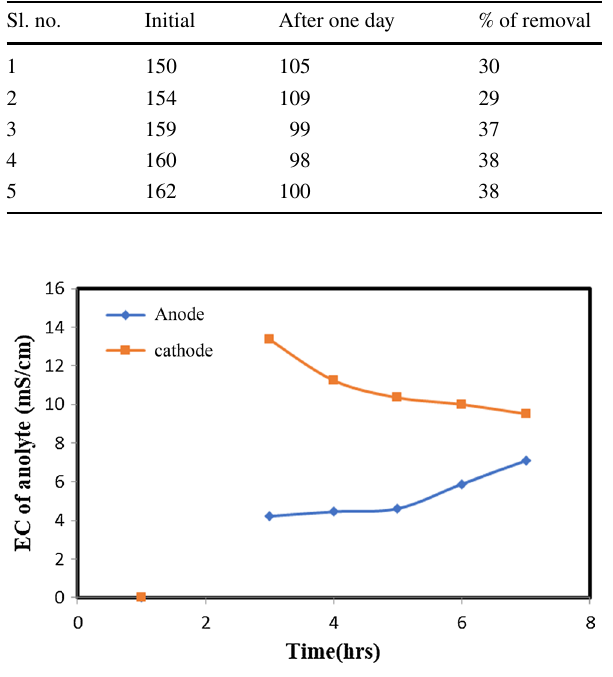
Fig. 6 Conductivity variation in anolyte and